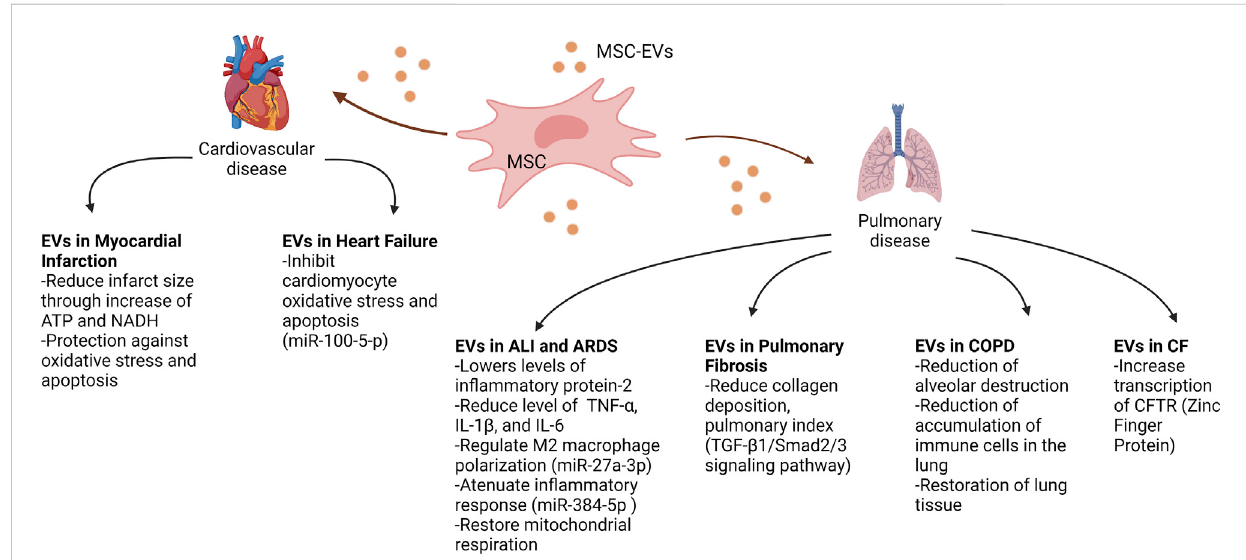
FIGURE 3 Therapeutic potential of mesenchymal stem cell-derived EVs on cardiopulmonary diseases. This fi gure demonstrates the various potential therapeuticeffectsofMSC-EVsonrecipientcells,improvingthephenotypicoutcomesofdiseasessuchasmyocardialinfarction,heartfailure,acutelung injury (ALI), acute respiratory distress syndrome (ARDS), pulmonary fi brosis, chronic obstructive pulmonary disease (COPD) and cystic fi brosis (CF). Abbreviations: MSC, mesenchymal stem cell; EVs, extracellular vesicles; ATP, adenosine triphosphate; NADH, nicotinamide adenine